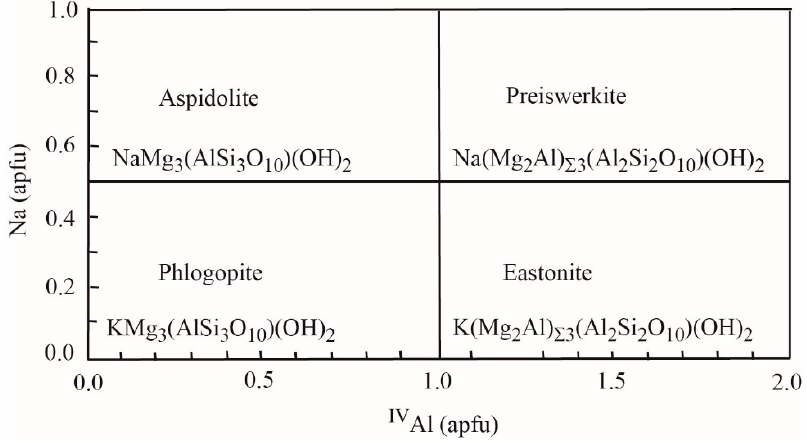
Figure 1. Classification diagram of trioctahedral (K,Na)-Mg